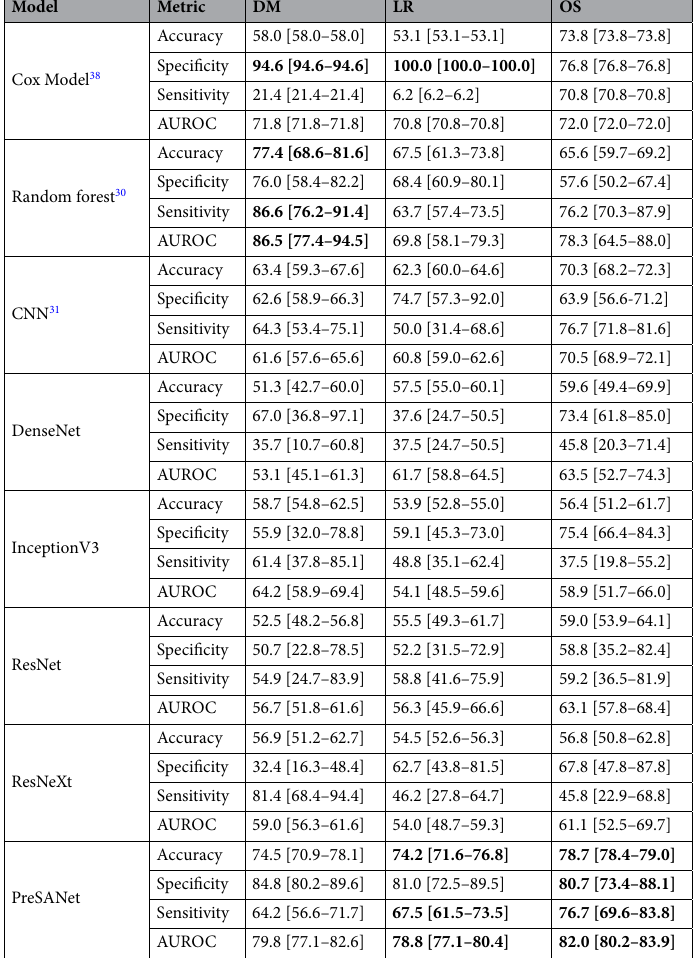
Table 2. Model comparison with previous works. Models were evaluated on split A, corresponding to the training and evaluation split presented by Vallieres et al. 30 . Off-the-shelf models were trained on a 2D image of the largest lesion slice, computed the same way as in the ablation study. Nomogram model 38 was calculated on the clinical data only. To obtain a 3 channel image required by these models, two repeated CT images and the PET image were concatenated. Figures reported are mean [95% Confidence Interval] for each of the 5 evaluated metrics, where available. Accuracy metric is normalized per class frequency. Bold corresponds to the highest value across Models for each Metric (Accuracy, Specificity, Sensitivity, AUROC) for each outcome (DM, LR,